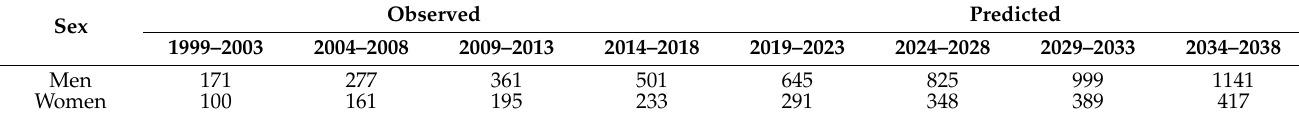
Table 3. Observed (1999–2018) and predicted cases (2019–2038) of malignant mesothelioma.